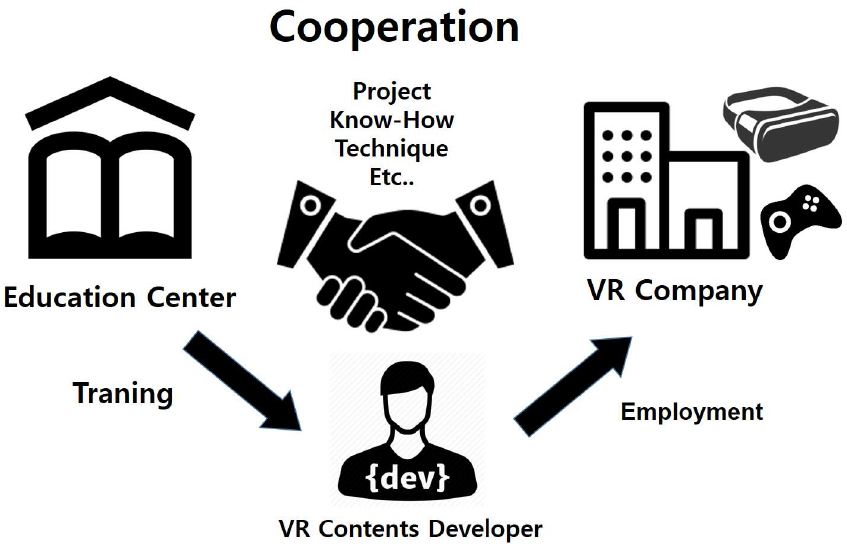
Figure 1. VR Contents Developer Educational Model Overview.